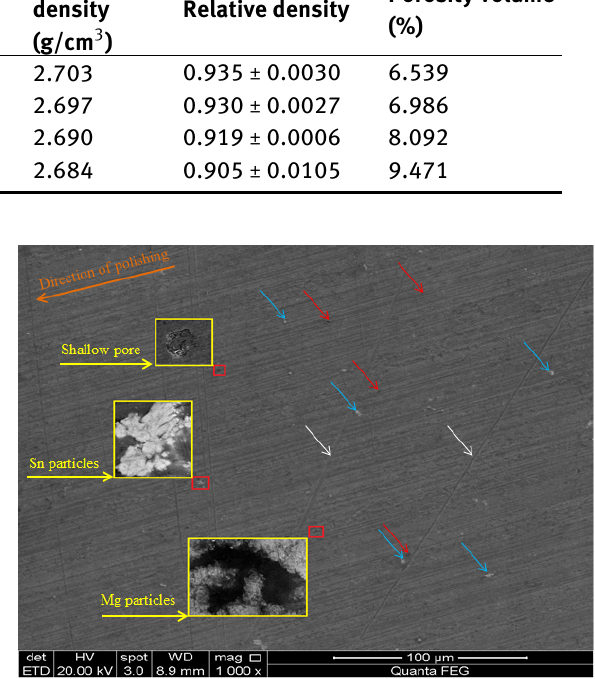
Figure 9: SEM micrographs of polished surface of Al-1.5Mg-1.5Sn matrix showing the lowest amount of porosity. Blue arrows indi- cate to Sn particles, red arrows indicate to Mg particles and white arrows indicate to scratches. Yellow squares represent higher mag- nification for red